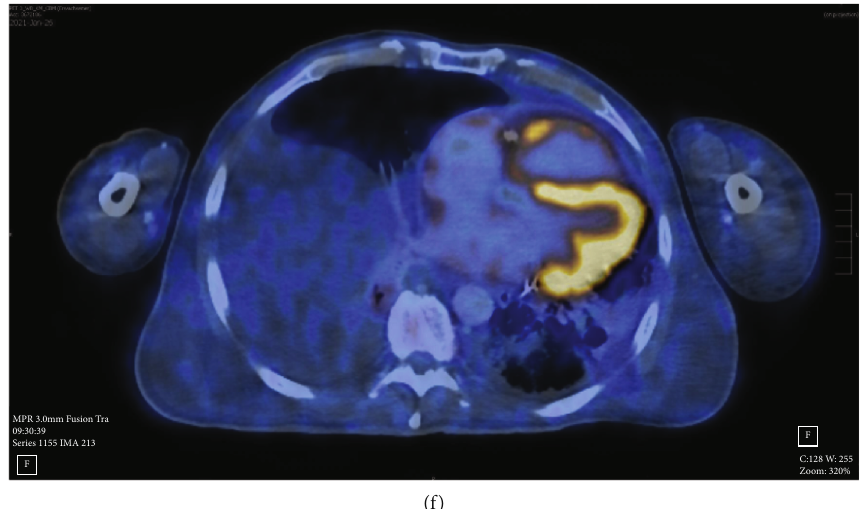
Figure 3: Cross-sectional studies con fi rmed myocardial in fl ammation. (a – d) Cardiac magnetic resonance imaging showing right ventricular hypertrophy (a, SSFP cine, ∗ ), increased T1 relaxation time (septal: 1062 ms, LV posterior wall: 1118 ms) and ECV of 33% (b, T1 map), increased T2 relaxation time to 52 ms septal and 60 ms in LV posterior wall (c, T2 map) and right ventricular, di ff use septal and left ventricular posterior wall late gadolinium enhancement (c, PSIR LGE, arrows) indicating myocarditis and di ff use biventricular fi brosis. (e, f) Positron emission tomography with computed tomography showing FDG uptake in the right ventricular myocardium (SUVmax 5.3), left ventricular uptake was within normal